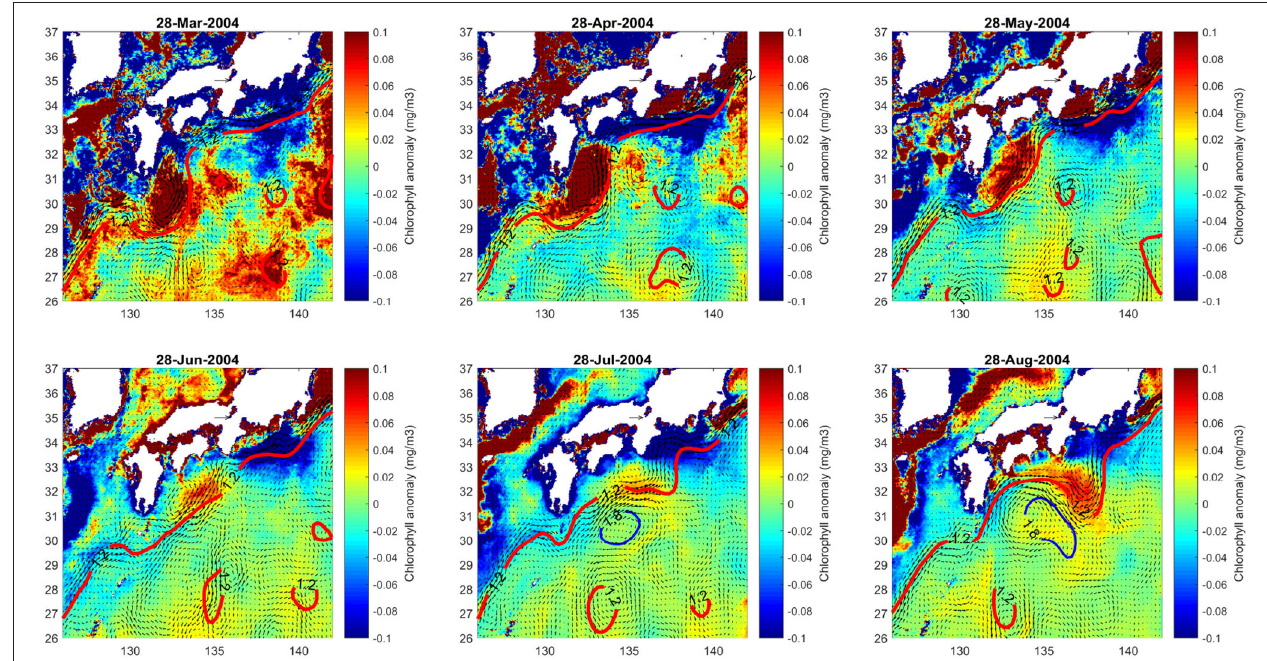
FIGURE 5 | The positive chlorophyll anomaly propagation from the south of Kyushu to the LM trough during the LM formation during the LM